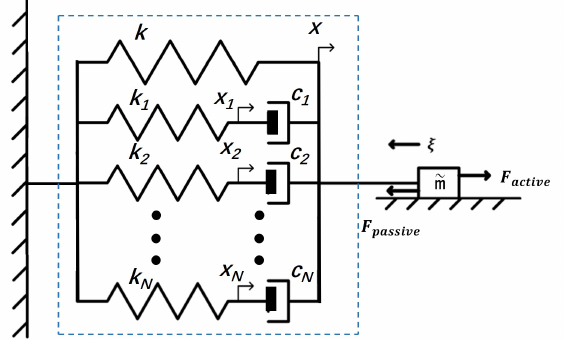
Figure 3. The dynamic model of the PAM, where k is the stiffness of the linear spring describing the static tensile force, x is the displacement of the linear spring, x h represents the spring deformation in the h -th spring–dashpot module ( h = 1,2, · · · , N , N is the system order), k h represents its spring stiffness, and c h shows its viscous friction coefficient, F active is the active driving force, ζ illustrates the resistance force during the motion, and F passive contains all the environmental stresses, ˜ m is the equivalent mass of the whole